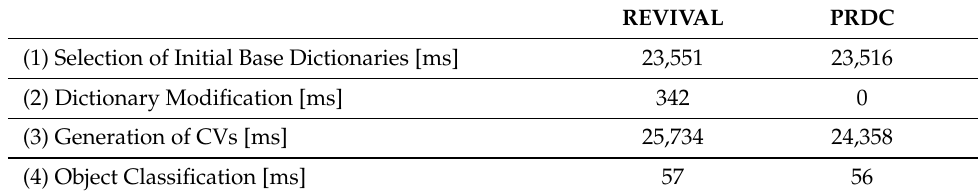
Table 3. Comparison of execution time between REVIVAL and